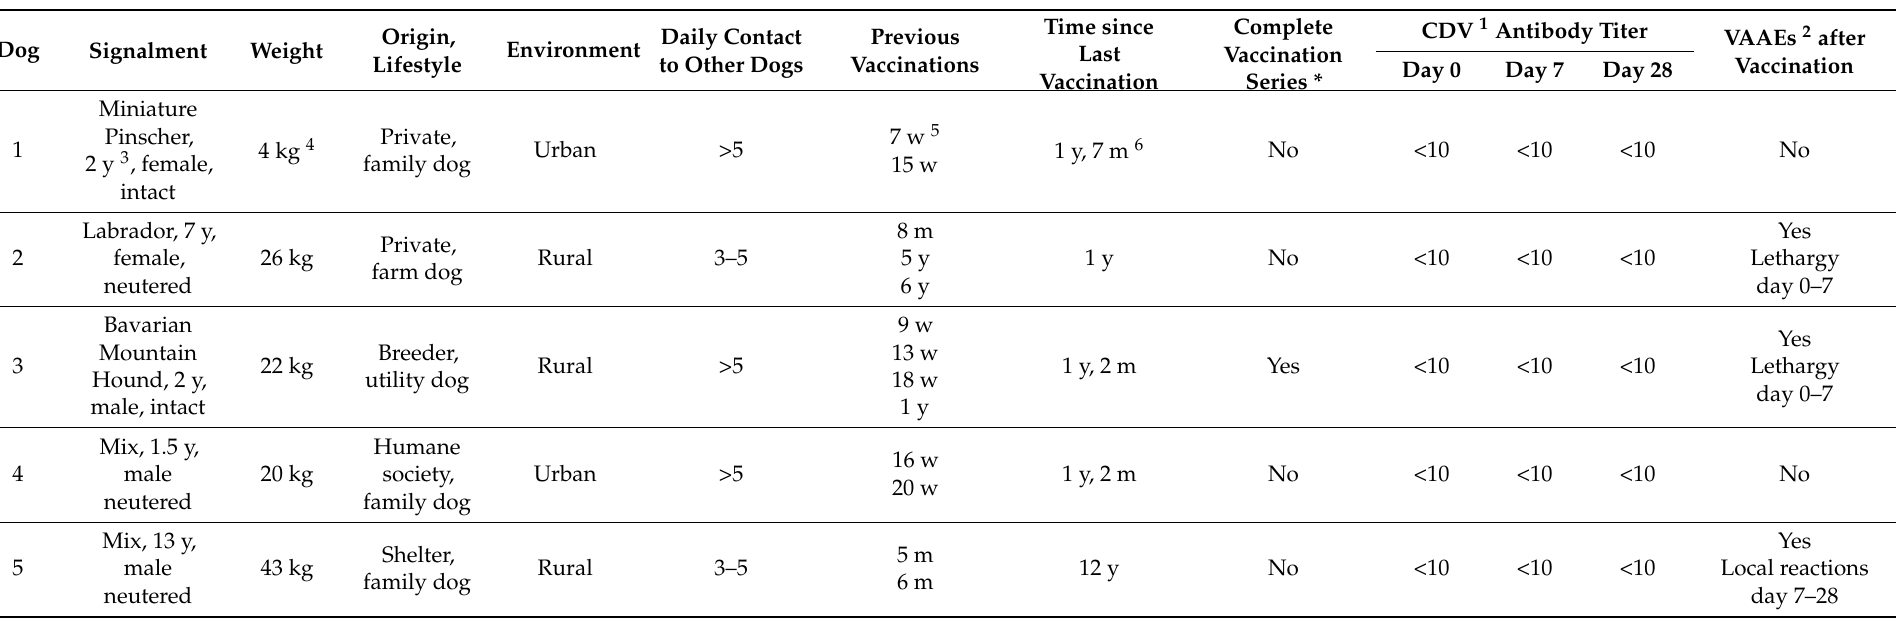
Table 4. Dogs without pre-vaccination antibodies against canine distemper virus isolate AG219 on day